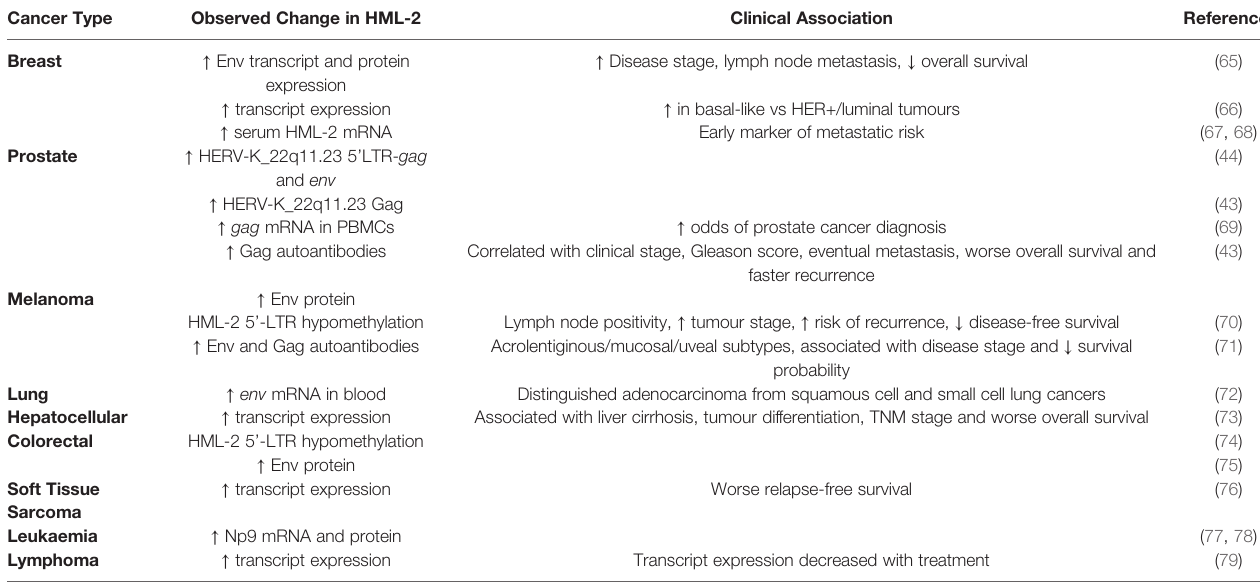
TABLE 1 | Summary of HML-2 alterations detected in patient specimens and their associated clinical